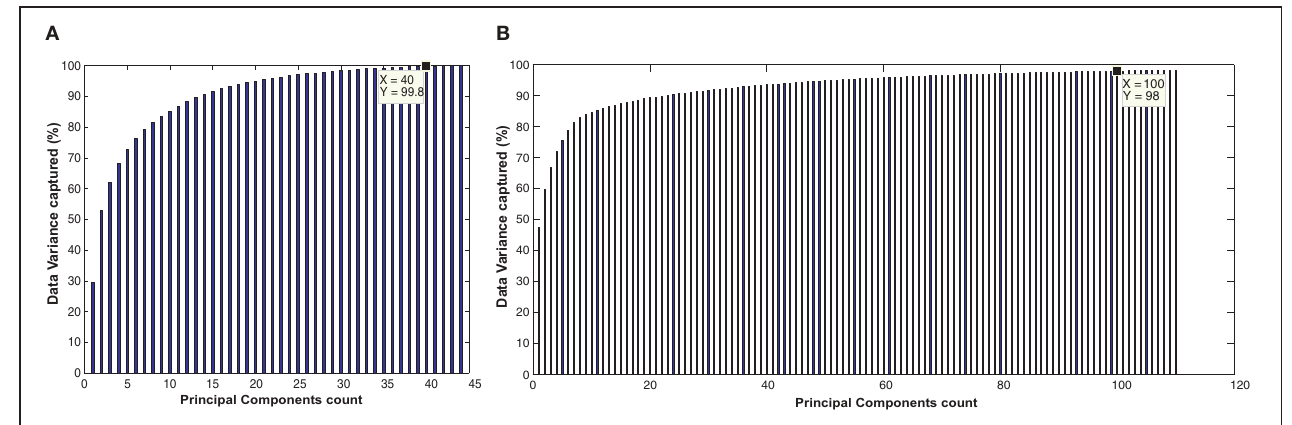
FIGURE A4 | The figure shows the plots of principal component count vs. percentage of data variance for (A) KKI training data (B) full training data of 776 subjects.